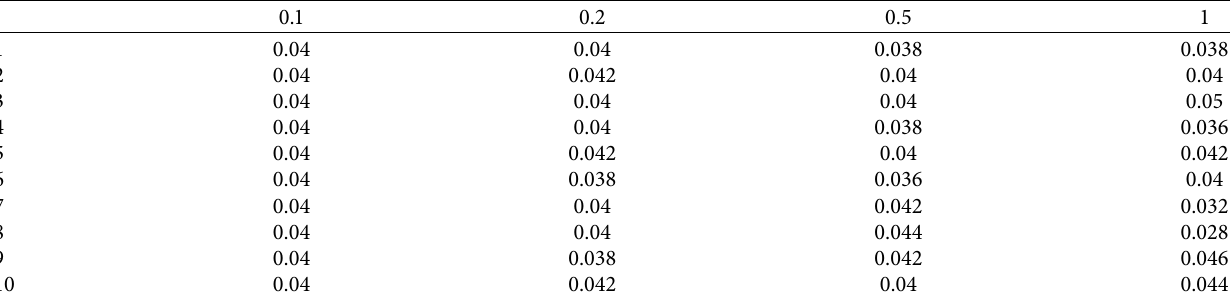
Figure 7: Illustration of the cross-correlation coefficient of signal with noise. Table 2: Delay time at different noise